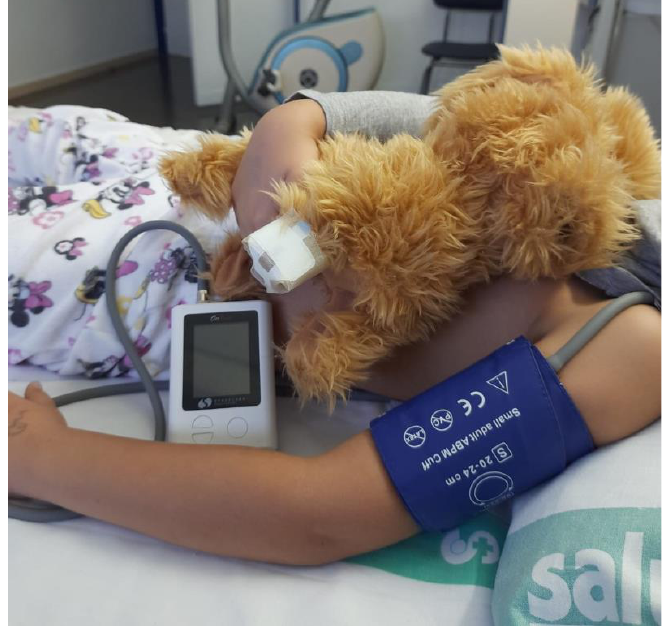
Figure 2. Ambulatory blood pressure monitoring.